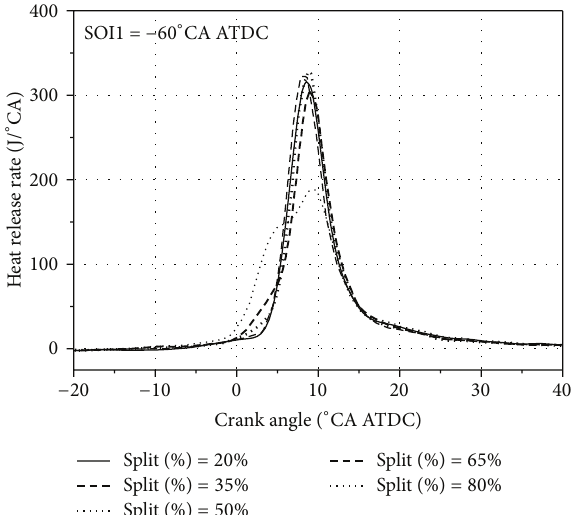
Figure 4: Heat release profile as a function of split percentage; SOI1 set at − 60 ∘ CA ATDC.